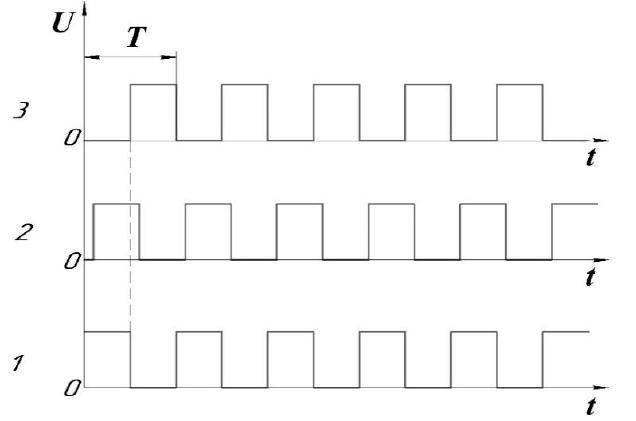
Figure 3. General view of the control